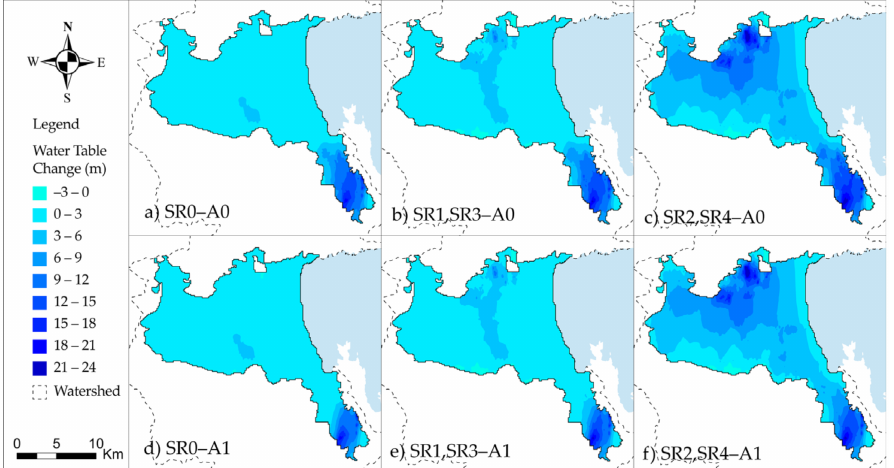
Figure 6. Hydraulic head changes of Almyros aquifer at the end of the simulation period (September 2018) between the baseline scenario (S0) and the various water resources and fertilization scenarios: ( a ) S0—(SR0-A0), ( b ) S0—(SR1, SR3-A0), ( c ) S0—(SR2, SR4-A0), ( d ) S0—(SR0–A1), ( e ) S0—(SR1, SR3–A1), and ( f ) S0—(SR2,